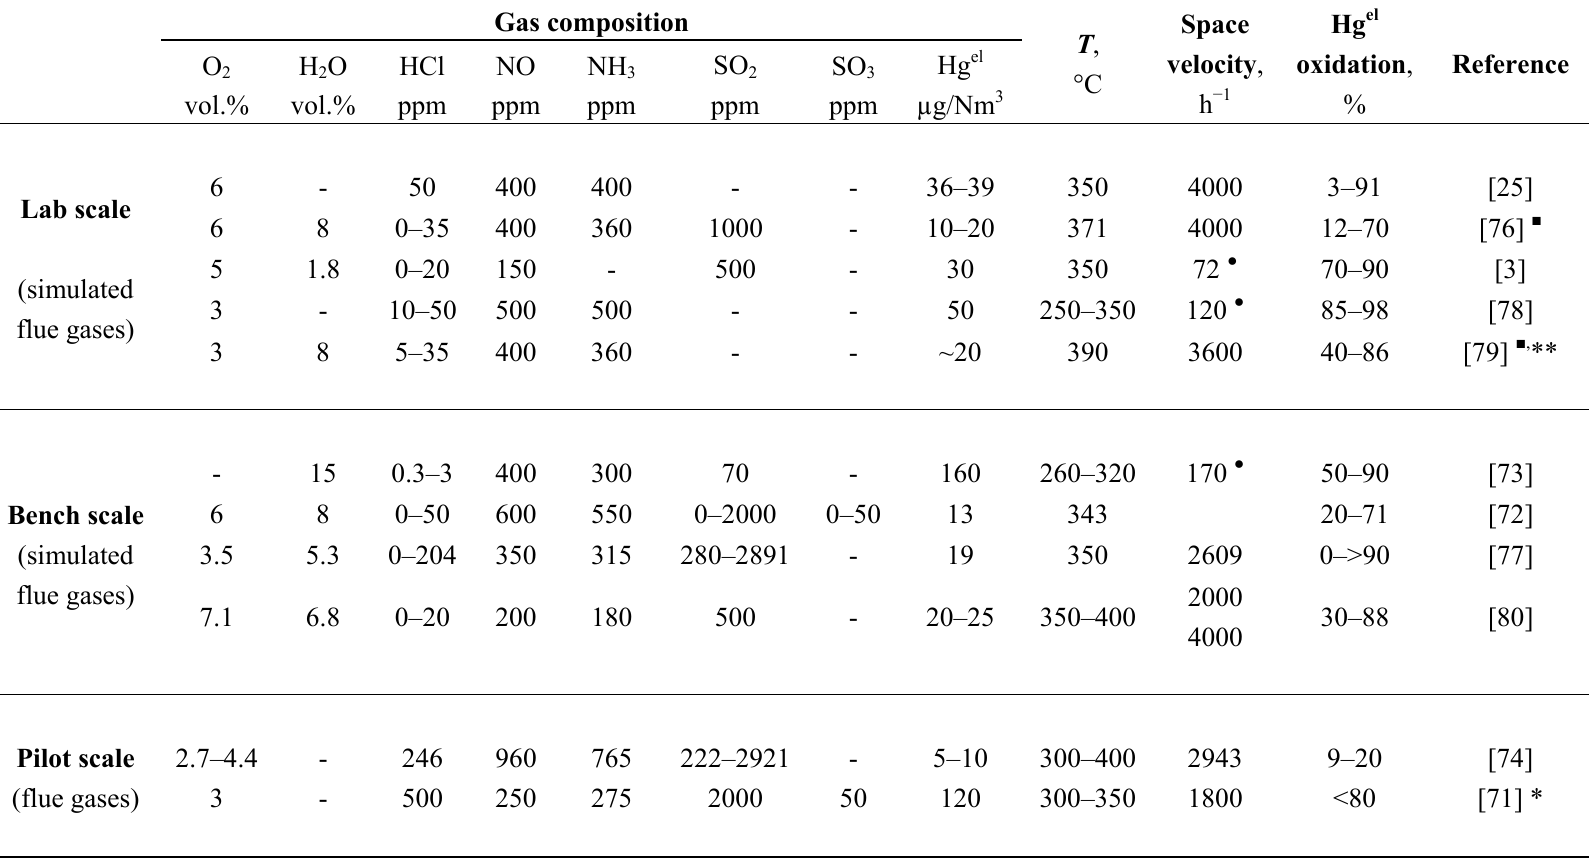
Table 3. Elemental mercury oxidation on SCR-DeNOx